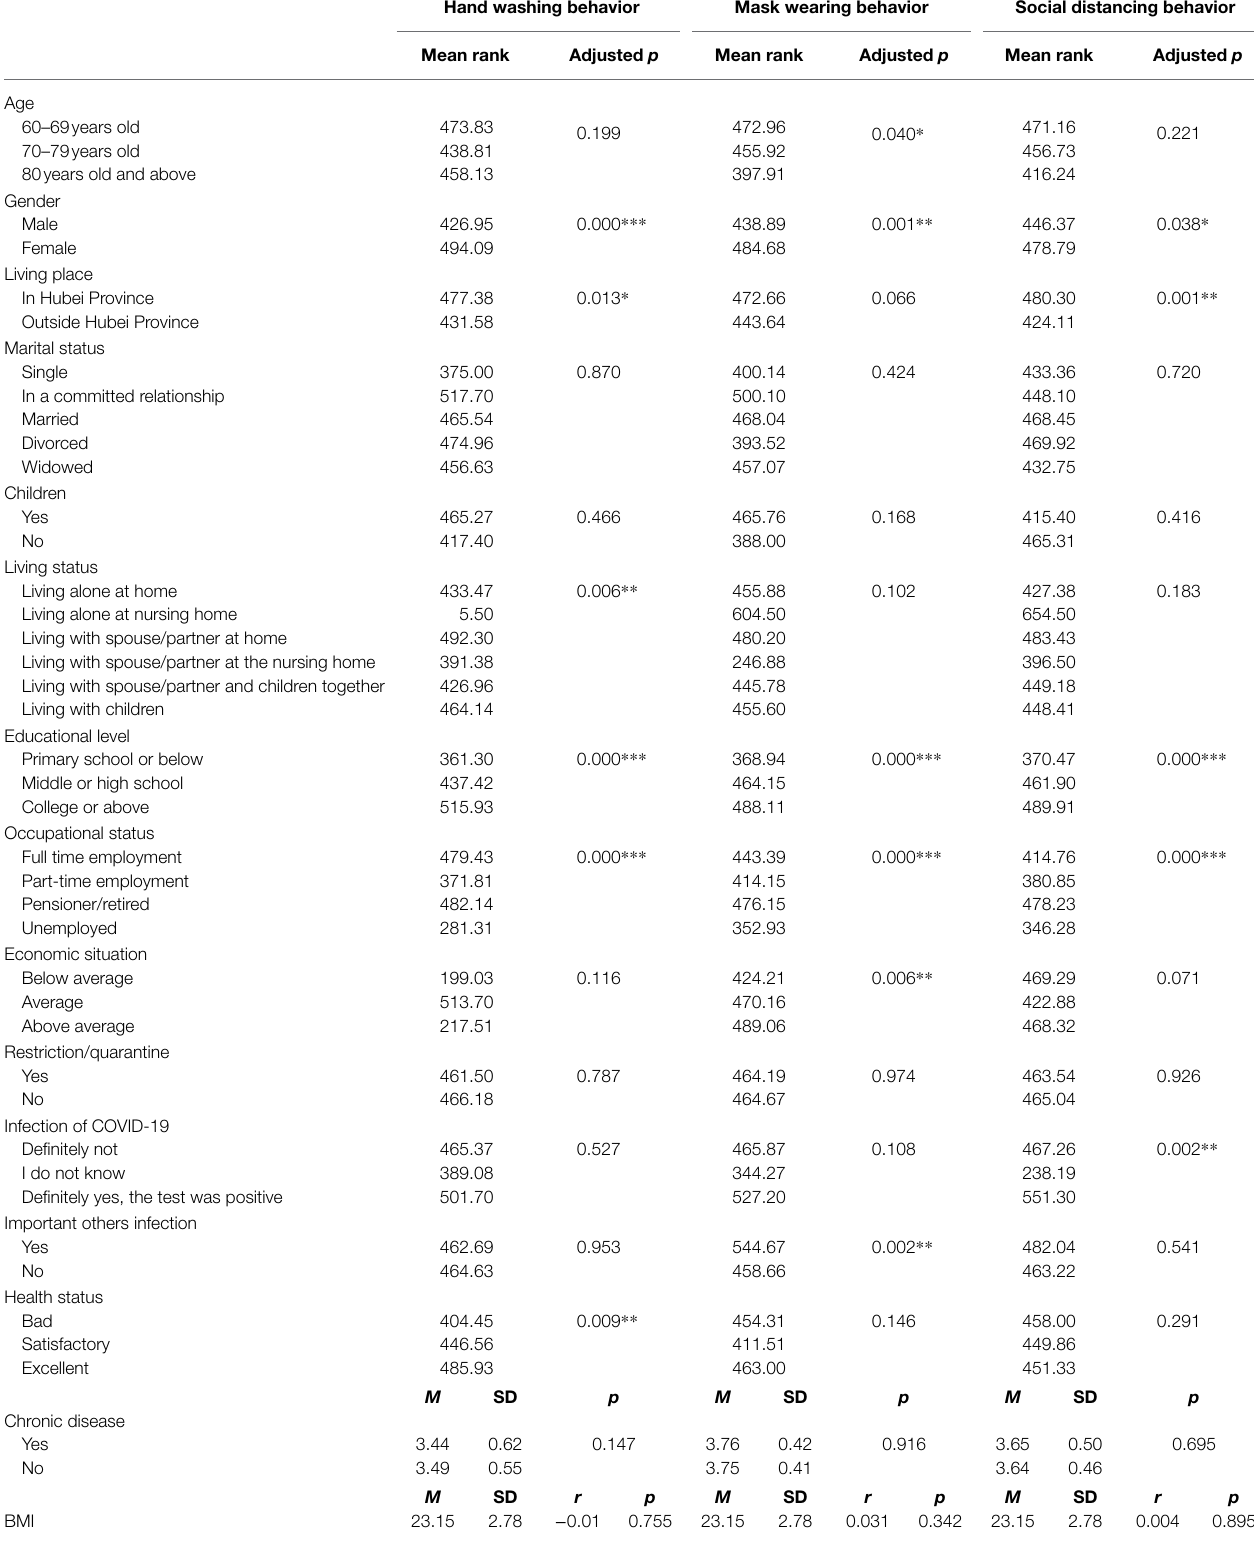
TABLE 3 | Demographic characteristics and differences on three preventive behaviors ( n =